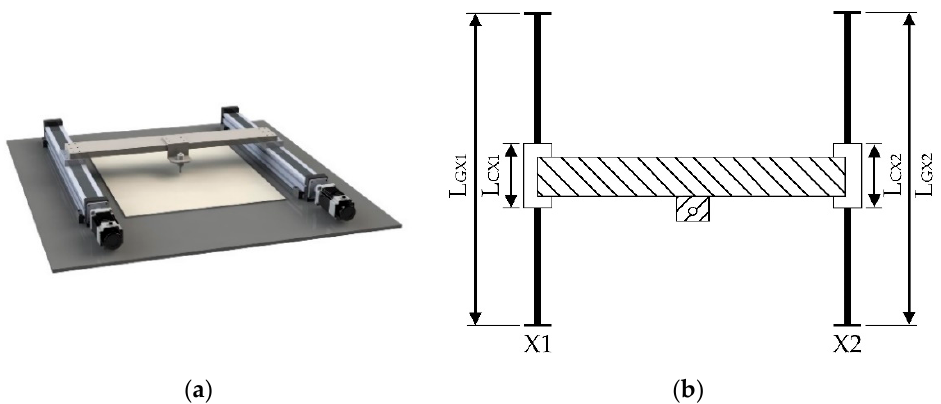
Figure 16. Parallel servo axes machine (gantry configuration). ( a ) 3D view; ( b ) MMCS top view. The motion command that defines and activates an electronic gear is called MC_GearIn. The name of the master servo axis, the name of the slave, and the relation of proportionality between their movements are indicated by its mains parameters. Once activated, it is enough for the master servo axis to move so that the slave servo axis pro- portionally replicates the movement. If the ratio is 1:1, the slave servo axis will behave as a duplicate of the master servo axis.